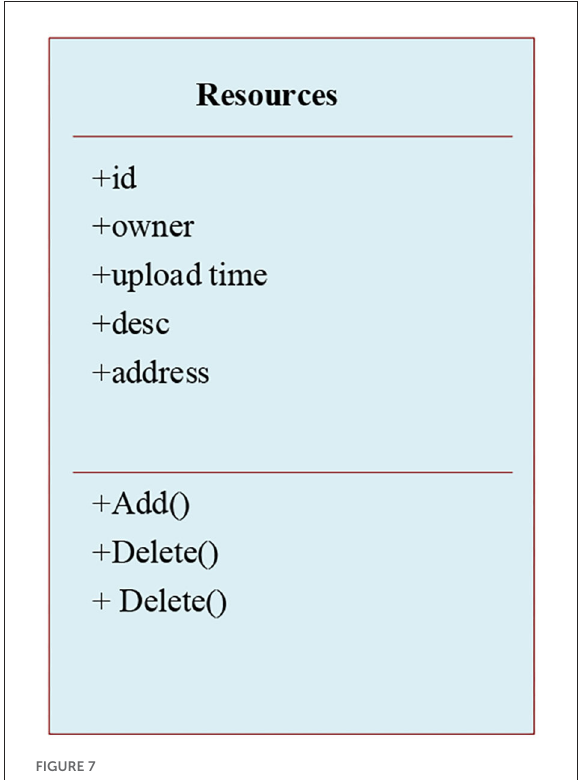
FIGURE7 Class diagram of micro-video management